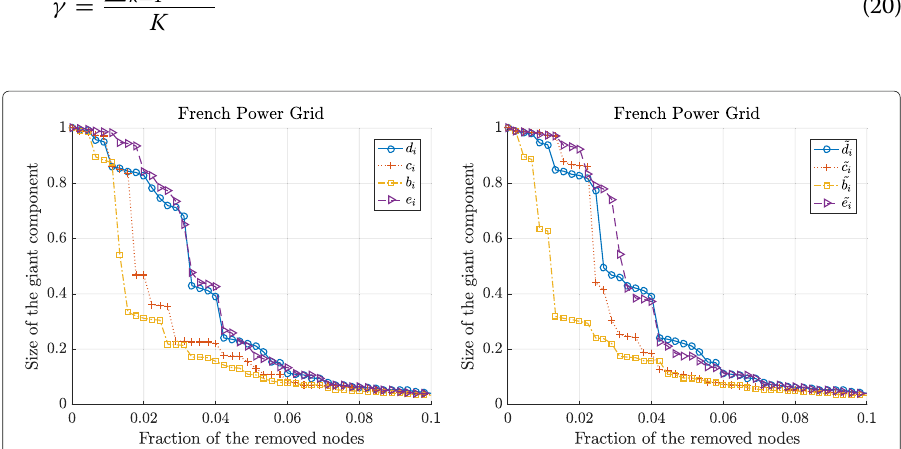
where σ( k ) is the normalized size of the giant component after k successive attacks. Sim- ilarly, the average value ¯ γ of the structural performance indicator of the power grid over K successive node-attacks is